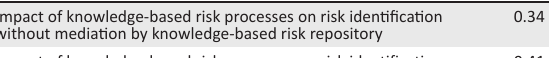
FIGURE 2: Factor analysis results.